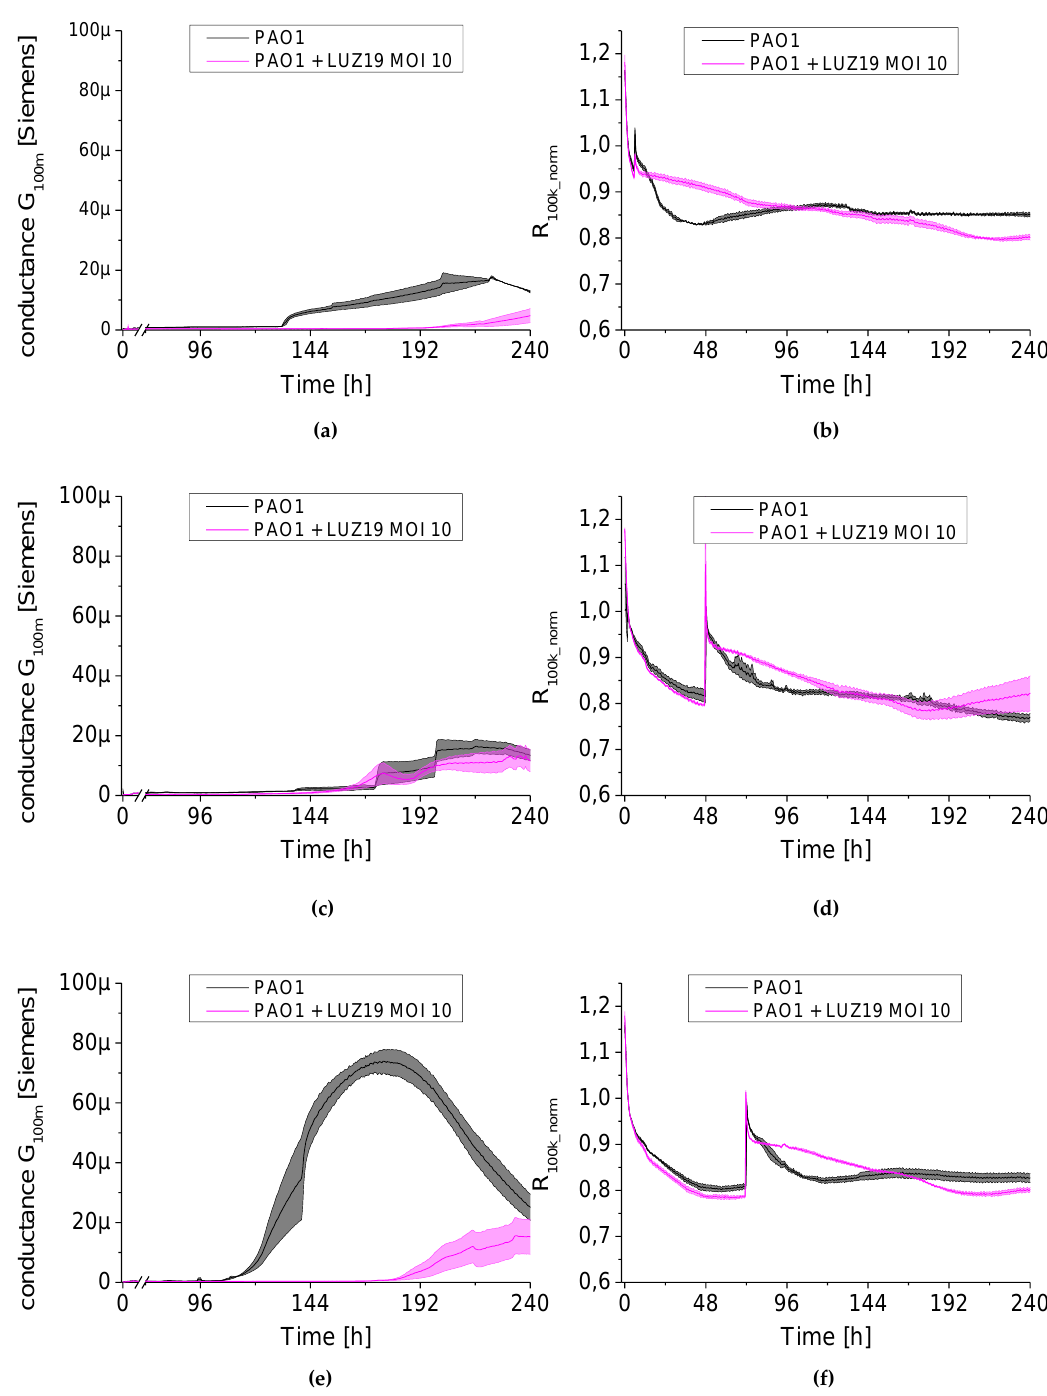
Figure 10. The changes in conductance G 100m (left panel) and resistance R 100k_norm (right panel) measured by QTF sensors during phage LUZ19 treatment of PAO1 biofilm at MOI = 10. Phage was applied at the 6th ( a , b ), 48th ( c , d ) and 72nd ( e , f ) hour of biofilm culture. In the right panel, for each variant, a peak appears, which is associated with the transfer of QTF sensors to new medium containing an appropriate concentration of viral particles. Data are expressed as mean of conductance G 100m ± SD and resistance R 100k_norm from three independent experiments.